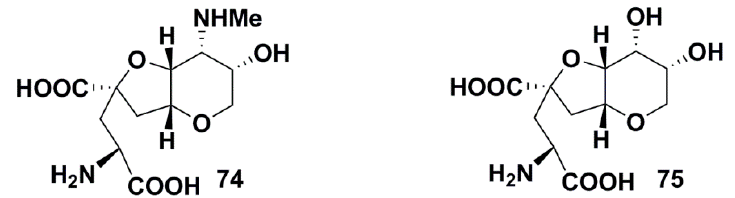
Figure 5. Structures of dysiherbaine ( 74 ) and neodysiherbaine ( 75 ).